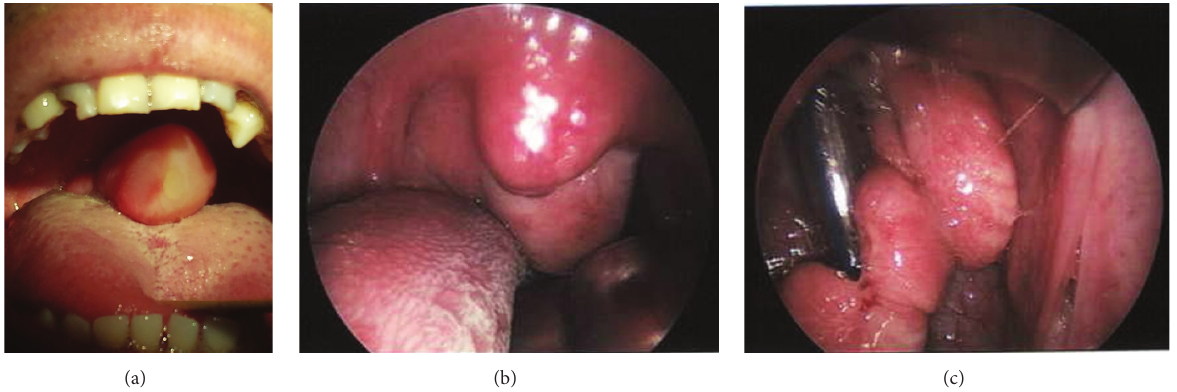
Figure 2: Flesh colored polypoid mass attached to the upper posterior nasopharyngeal wall on initial presentation (a), 36 hours after presentation when patient had been treated with steroids and intravenous antibiotics (b) and following transnasal endoscopic and transoral resection (c).